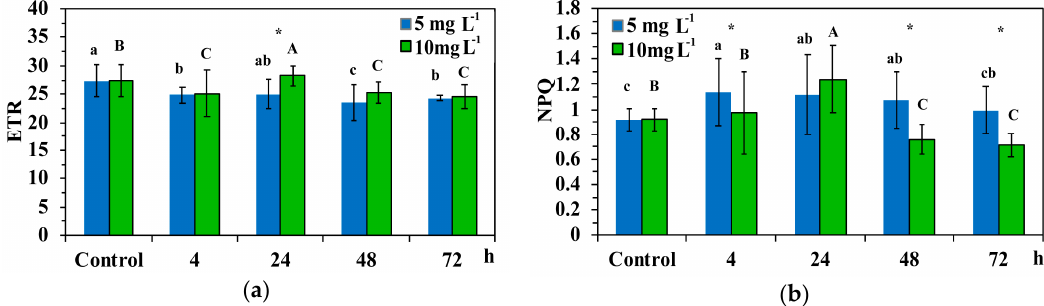
Figure 7. The relative electron transport rate of PSII (ETR) ( a ); and the non-photochemical quenching (NPQ) ( b ), in control leaf blades of C. nodosa and in leaf blades exposed to 5 mg L − 1 and 10 mg L − 1 ZnO NPs for 4 h, 24 h, 48 h and 72 h. Symbol explanations as in Figure 5. 3.5. The Redox State of Plastoquinone Pool of Cymodocea nodosa Leaf Blades Exposed to ZnO NPs The redox state of plastoquinone (PQ) pool (a measure of PSII open reaction centers) ( q p ), did not − 1 di ff er compared to control values after 4 h, 24 h, and 48 h exposure to 5 mg L ZnO NPs but reduced after 72 h (Figure 8). PQ pool reduced compared to control values after 4 h, 48 h and 72 h exposure